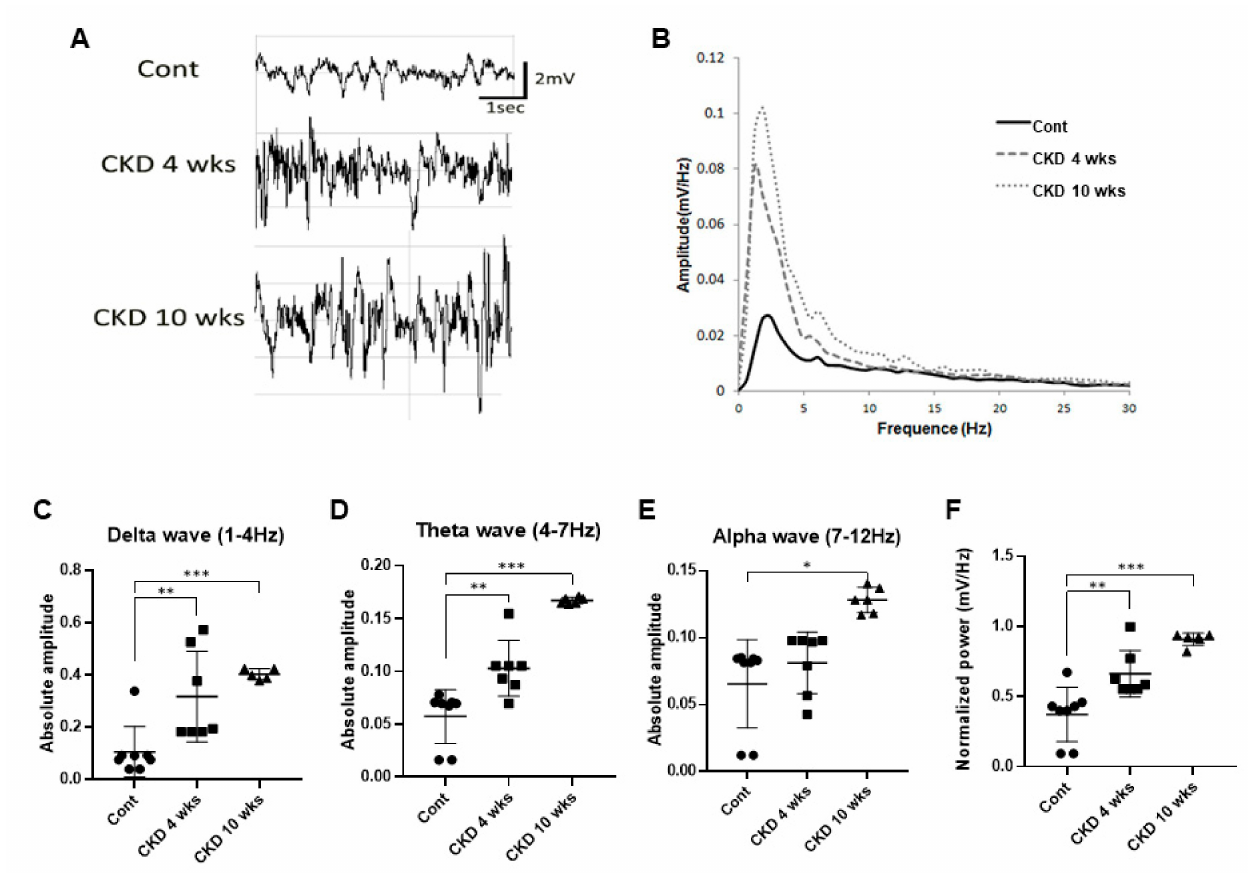
Figure 5. Neural oscillations at 1–12 Hz in the CA1 region of hippocampus of CKD and wild-type rats. Representative LFP signals in the hippocampus of wild-type rats under urethane-induced anesthetic ( A ). The LFP profiles of each CKD rat showed epileptic discharges as large amplitude spikes of irregular sharp waves and multiple spikes ( A ). Power spectral analysis of the CKD rats revealed higher power at a lower frequency more than in the wild-type group ( B ). Hippocampal delta and theta oscillations were markedly elevated in the CKD 4 weeks and 10 weeks-recovered CKD rat model ( C , D ), hippocampal alpha rhythm was increased in the 10 week, but not the 4 weeks, recovered CKD rats ( E ). The average normalized power after CKD rats was stronger than in wild-type rats ( F ). Data are presented as means ± standard errors of the mean. * p < 0.05, ** p < 0.01, and *** p < 0.001, one-way analysis of variance ( C – F